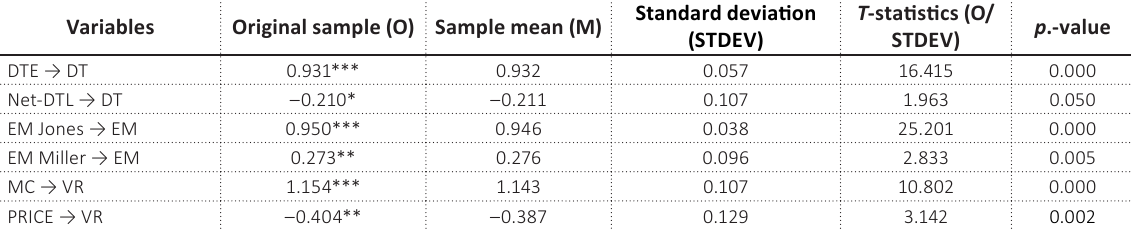
Source: Data processed for